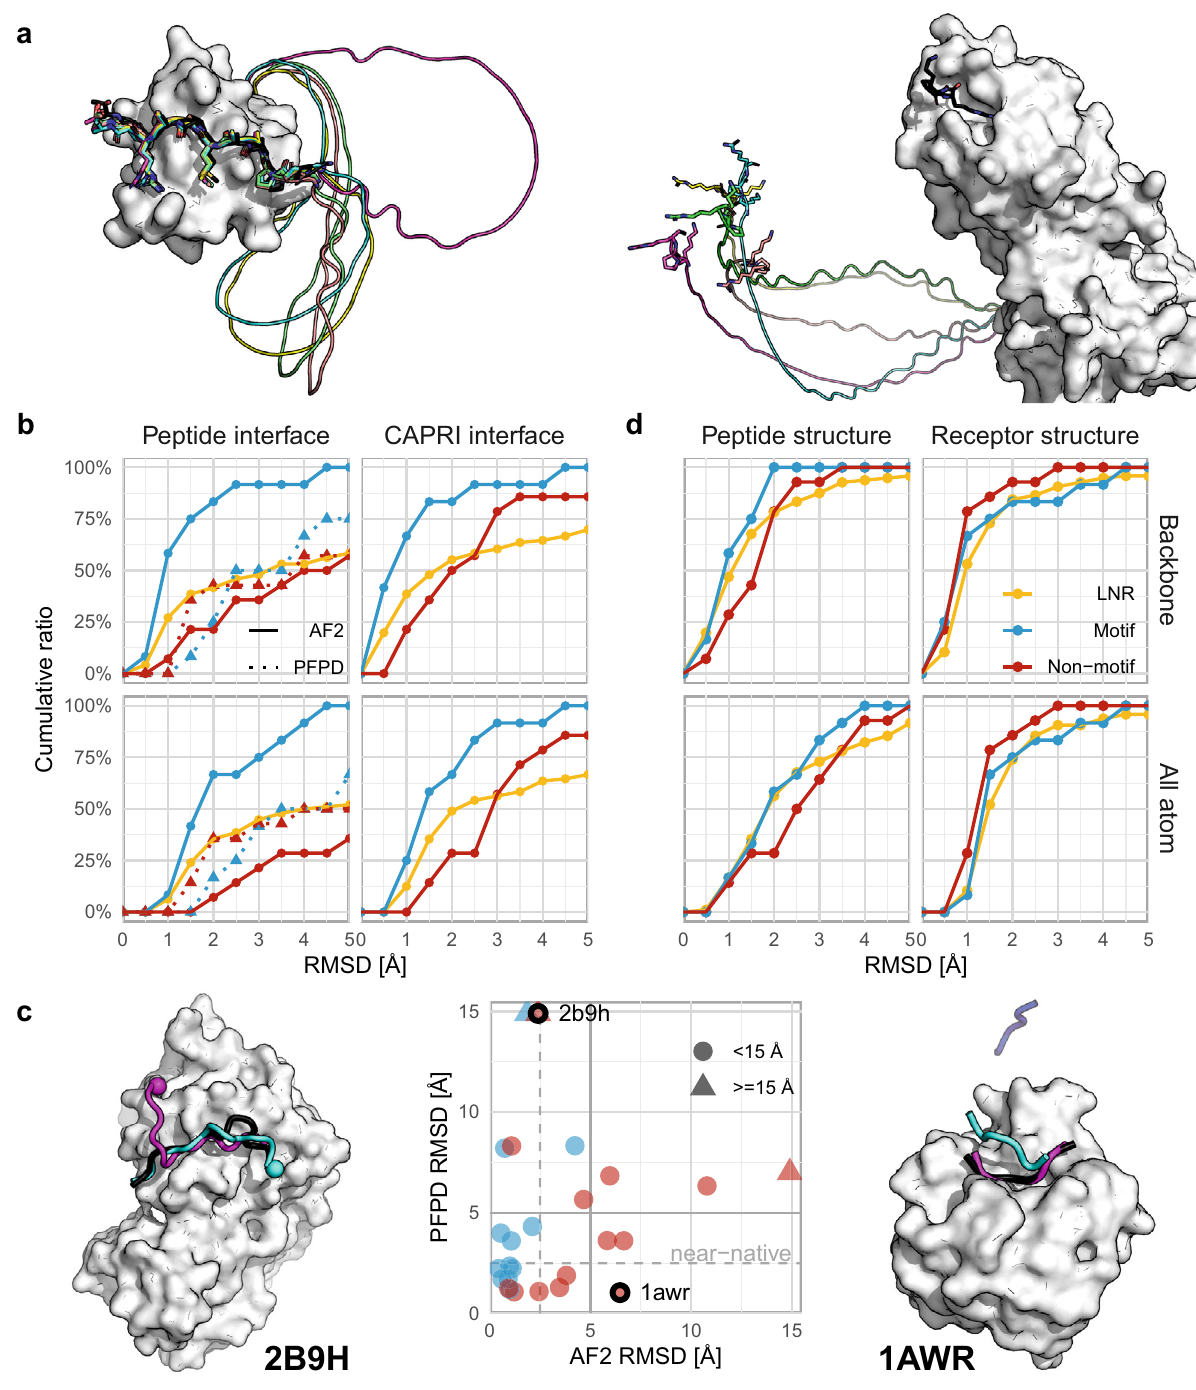
Fig. 1 AF2 can be adapted to accurately model many peptide – protein interactions. a Concept of peptide – protein docking with a poly-glycine linker, successfully identi fi ed as unstructured region and modeled as a circle, placing the peptide at its correct position (left; example PDB ID 1ssh 63 ), or out in space (right; example PDB ID 2orz 64 ). The native peptide is shown in black. b Cumulative performance of AF2 and PFPD (dashed lines) on motif (12 complexes, blue), non-motif (14 complexes, red), and LNR (96 complexes, AF2 only, yellow) sets, as measured over the interface residues of the peptide (Left - Peptide interface: after aligning the receptor) or the full interface (Right - CAPRI Irms: after aligning the whole interface. See also Supplementary Fig. 2). c Correlation between performance of AF2 and PFPD for the motif and non-motif PFPD sets. Triangles indicate values over 15.0 Å RMSD. Left: PDB ID 2b9h 38 , interaction between MAPK Fus3 and a peptide derived from MAPKK Ste7, where PFPD positions the peptide within the pocket, but in a fl ipped orientation (N-termini are indicated by spheres). Right: PDB ID 1awr 65 , interaction between CypA and a HIV-1 Gag polyprotein derived peptide, where AF2 models the peptide within the pocket but in a wrong position. Shown are the peptide structures generated by the linker model (cyan, blue) or PFPD (magenta), and the crystal structure (black). d Overall assessment of performance measured for the individual partners (after aligning each separately). Source data are provided as a Source Data fi